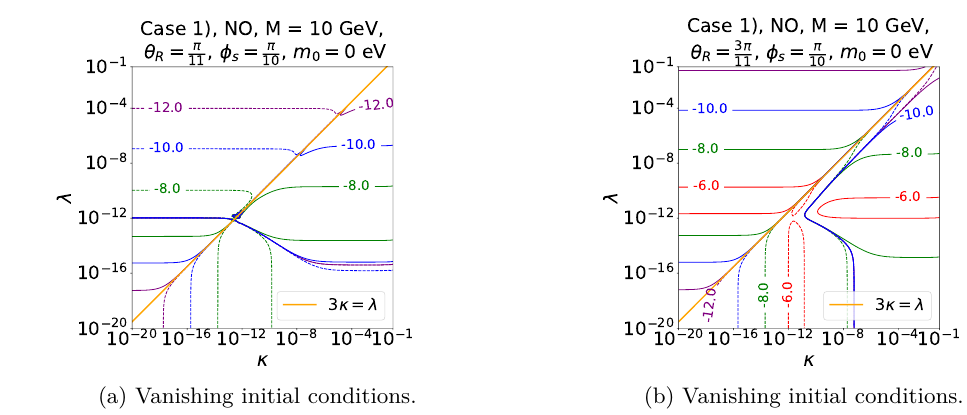
Figure 11 . Case 1) Contour plots of Y B as function of both splittings κ and λ for two different values of the angle θ , θ = π (left plot) and θ = 3 π (right plot). Iso-BAU lines are represented R R R 11 11 in the κ − λ -plane; note − 12 . 0 has to be read as 10 − 12 and alike. We, furthermore, show the line corresponding to 3 κ = λ in orange for which two of the heavy neutrinos become degenerate in mass, compare eq. (6.14), and the BAU vanishes, see eqs. (6.17) and (6.18). The Majorana mass is fixed to M = 10 GeV, light neutrino masses follow strong NO and φ is fixed to φ = π s s 10